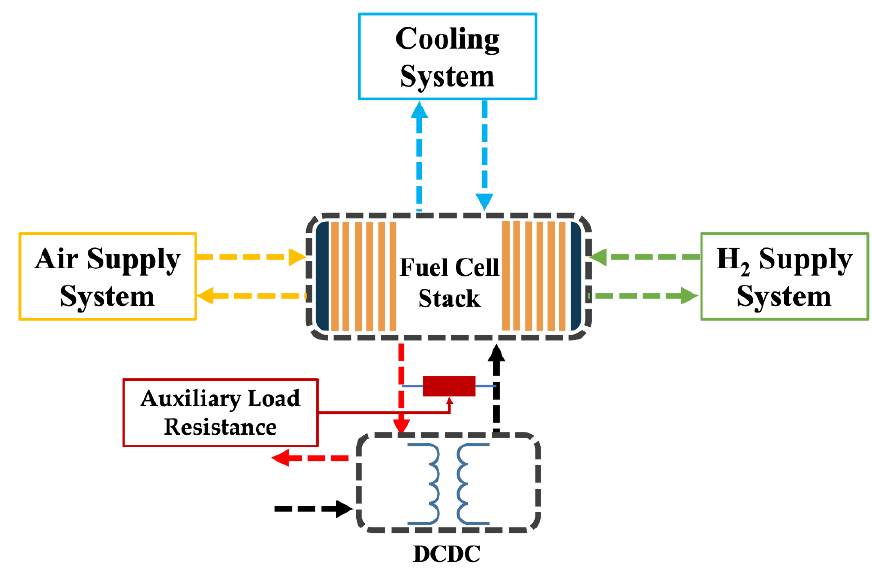
Figure 1. The schematic diagram of the PEMFC system testbench.